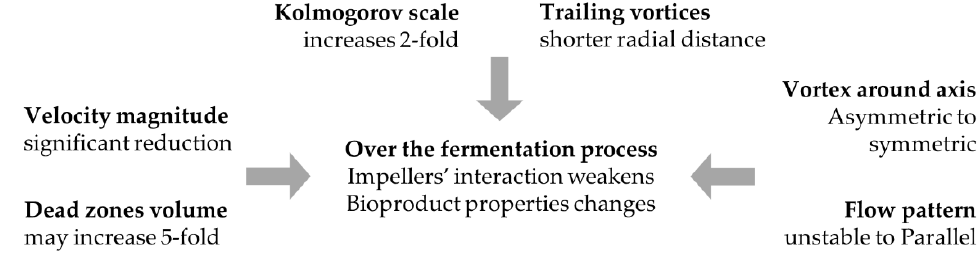
Figure 11. Impact of evolving fermentation broth pseudoplasticity on mixing mechanisms of stirred